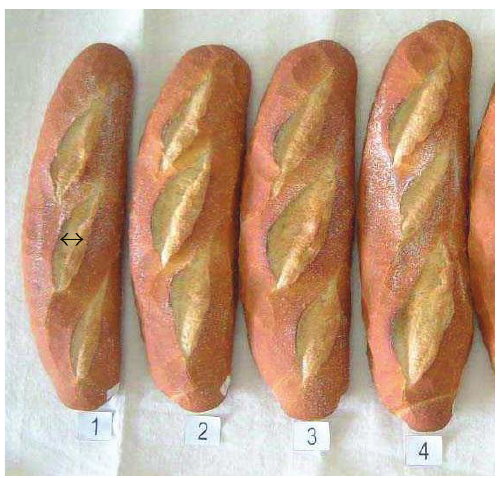
F 14: Effects of xylanases on bread volume and cut width (arrows) as compared to a negative control without added xylanase (loaf 1). Adapted from